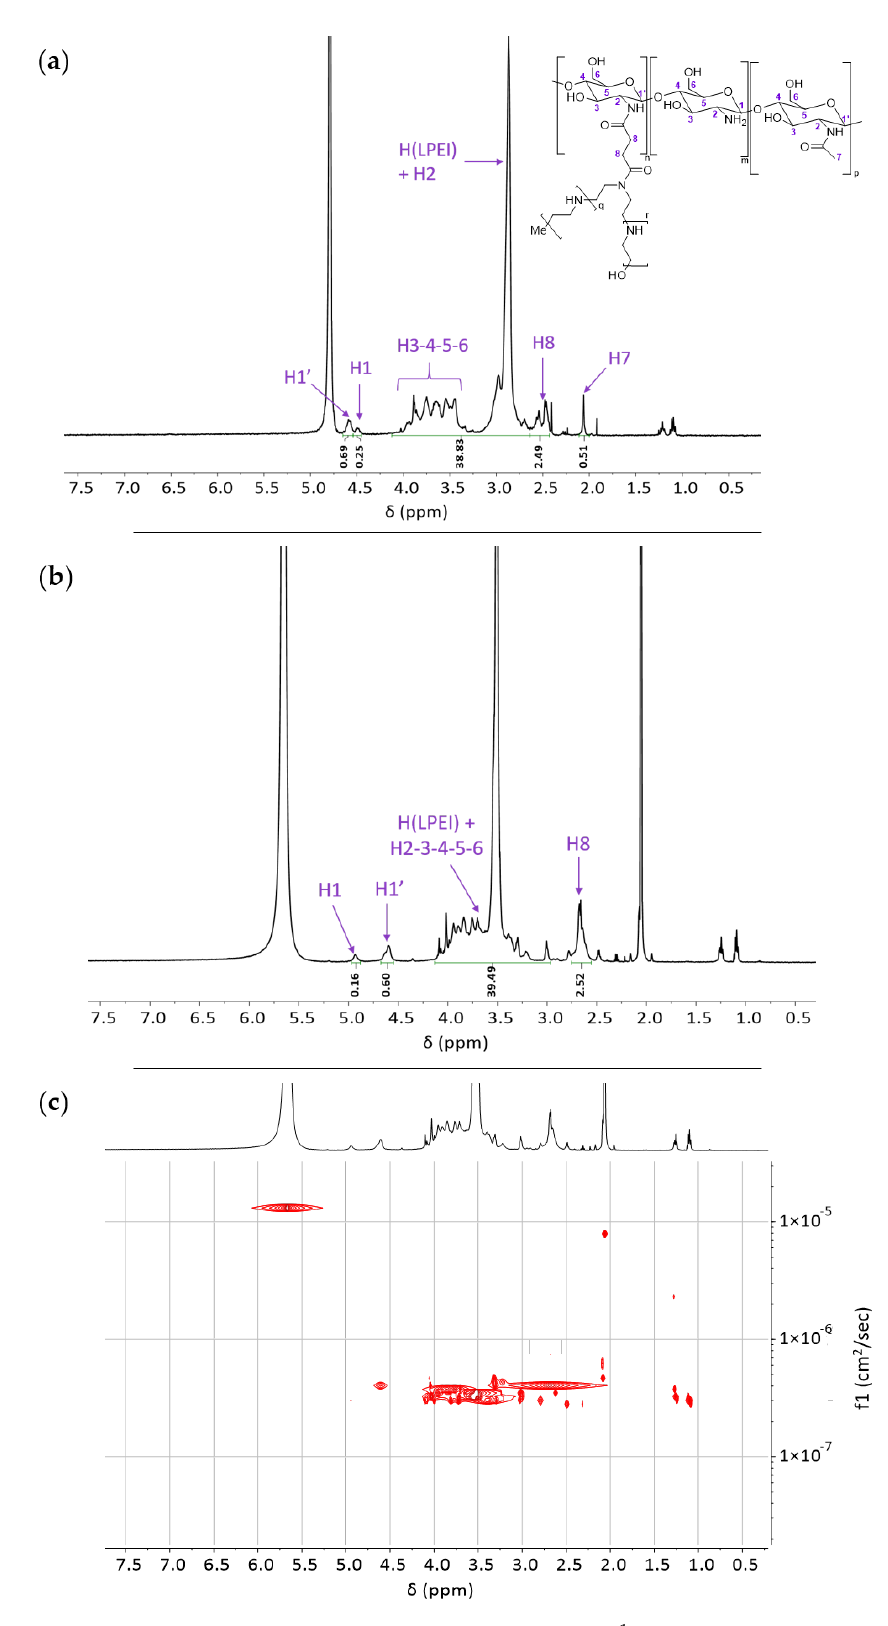
Figure 3. NMR characterization of dCS-Suc-LPEI-14 . ( a ) 1 H NMR spectrum in D 2 O and ( b ) in D 2 O/acetic acid-d 4 . ( c ) Determination of the covalent bonding of dCS-Suc-LPEI-14 by 2D-DOSY NMR in D 2 O/acetic acid-d 4 . For details on analyses and assignments, cf. Supporting information